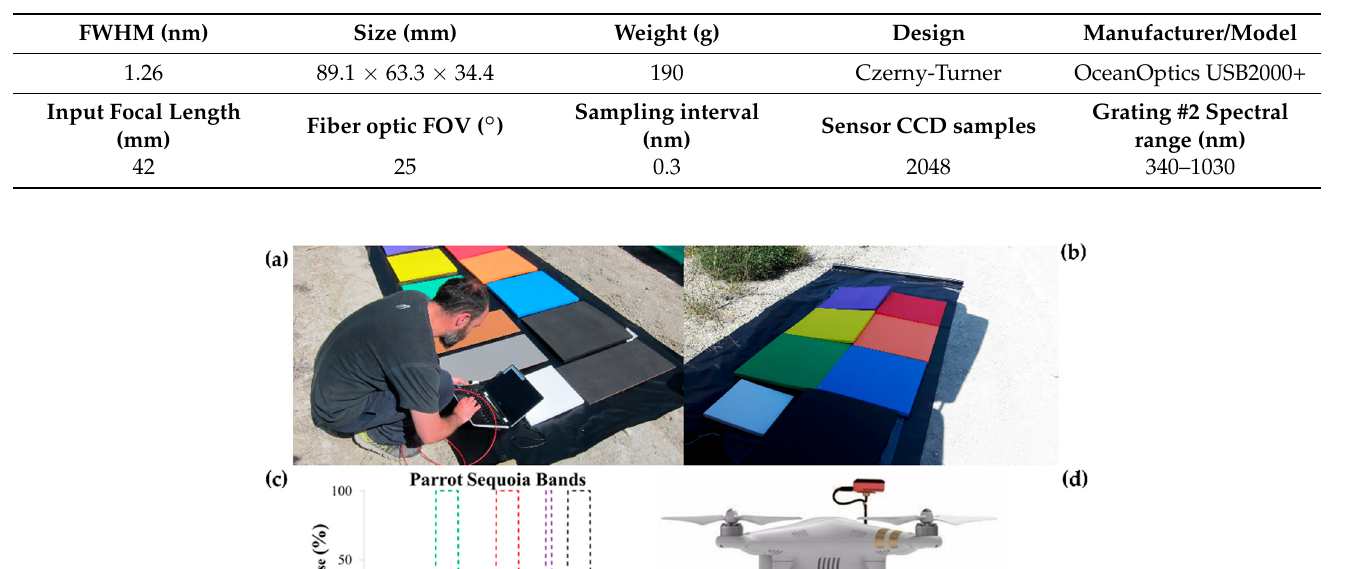
Table 2. Field spectroradiometer main features (OceanOptics USB2000+).